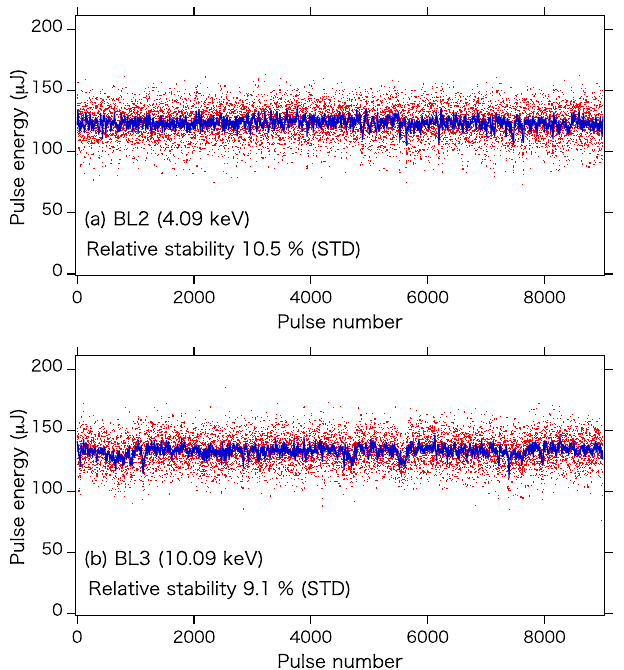
FIG. 12. Stability of the photon pulse intensity measured by an intensity monitor in the multi-beam-line operation combined with the multienergy operation of the accelerator, (a) BL2 and (b) BL3. Red points represent single-shot results and blue lines show averaged values over 15 shots. The pulse repetition at each beam line was 15 Hz and the full horizontal scale corresponds to 10 minutes. The electron beam energy of BL2 was 6.3 GeV and that of BL3 was 7.8 GeV. The undulator K-values were 2.85 and 2.1 for BL2 and BL3, respectively. The peak current is 1.2 kA for both beam